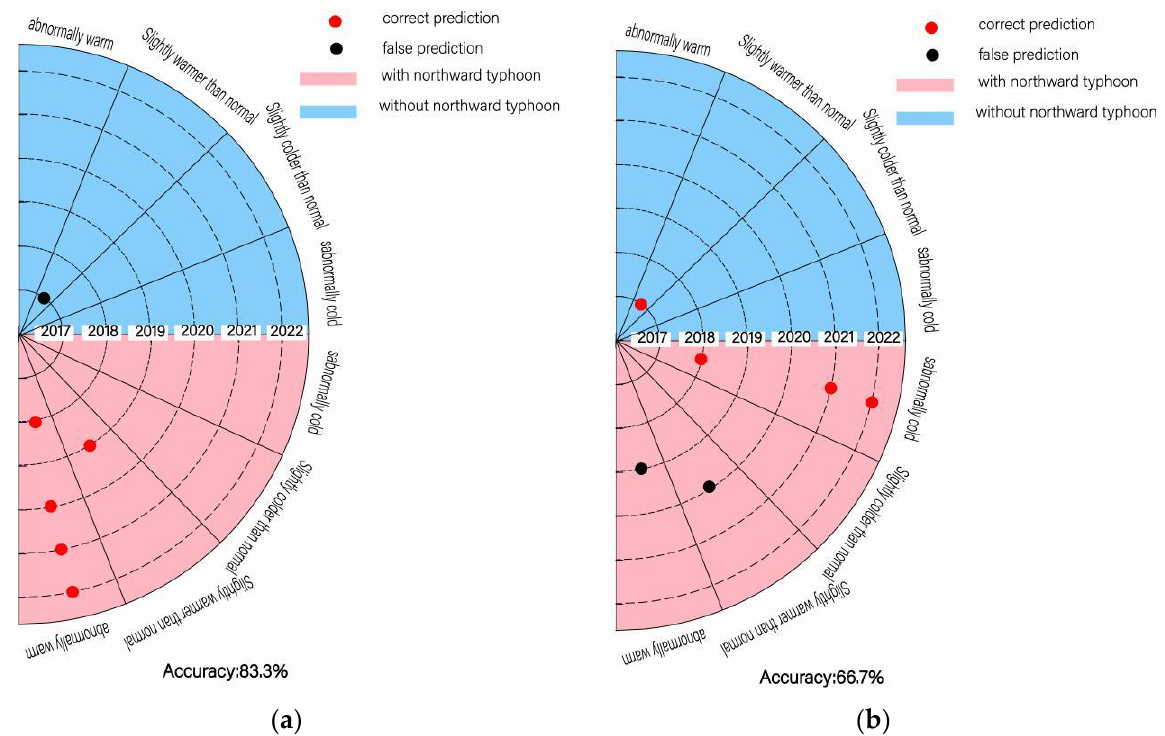
Figure 11. Forecast accuracy of northward-moving typhoons using ( a ) the SST in the west-wind-drift zone and ( b ) the Nino 3 SST from July to September.